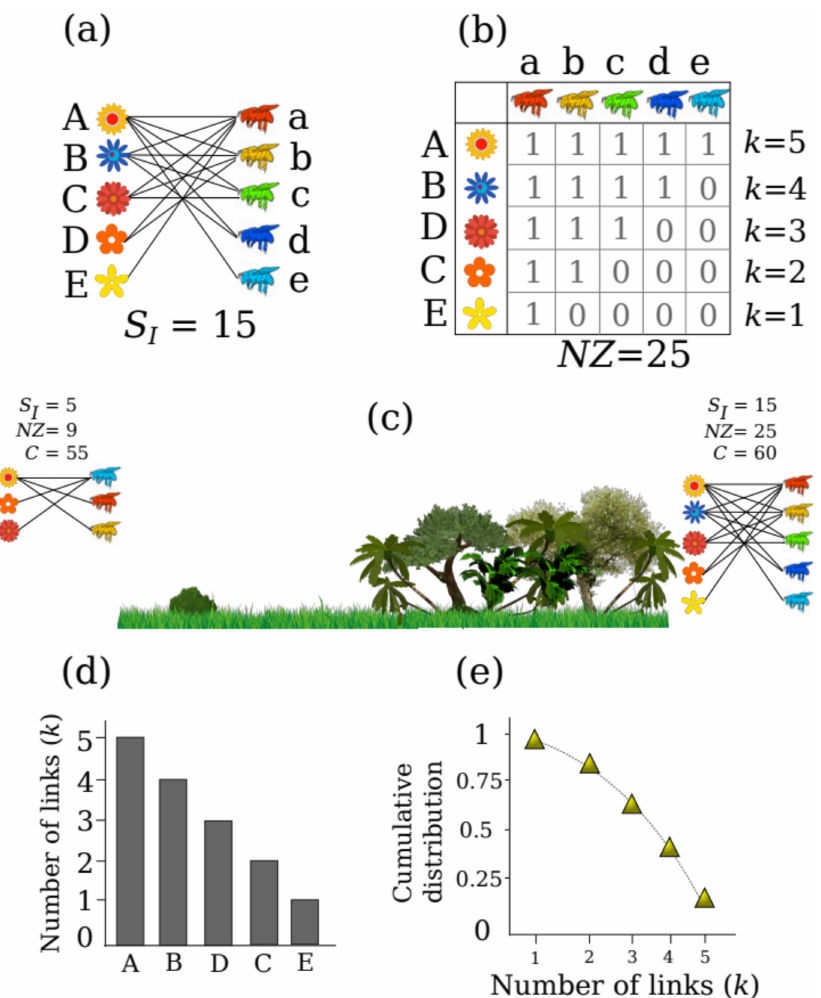
Figure 1. ( a ) Local network formed by nodes denoting five plant species (left) and five floral visitor species (right); the links represent the interactions between the species. In this bipartite network, nodes can be subdivided into two trophic levels (i.e., plants and pollinators) and interactions only occur between nodes of di ff erent trophic levels. If we count the number of di ff erent lines, we obtain the interaction richness S I . ( b ) Interaction matrix from which the network ( a ) was drawn, the numbers in the right represent the number of links per species k (i.e., degree). If we multiply the number of plant by the number of floral visitors, we obtain the network size (NZ). Each dimension of the matrix represents just one trophic level (e.g., rows = plants; columns = pollinators). ( c ) Hypothetical representation of the interaction of two communities (pasture and jungle), each network represents the interactions of each habitat, and the values below them describe its local properties S I , NZ and realized interactions ( C ). ( d ) Degree distribution plot of the network: we can see that we have a species with a high degree (five links) and some species with a low degree (one or two links). ( e ) Cumulative degree distribution following a truncated